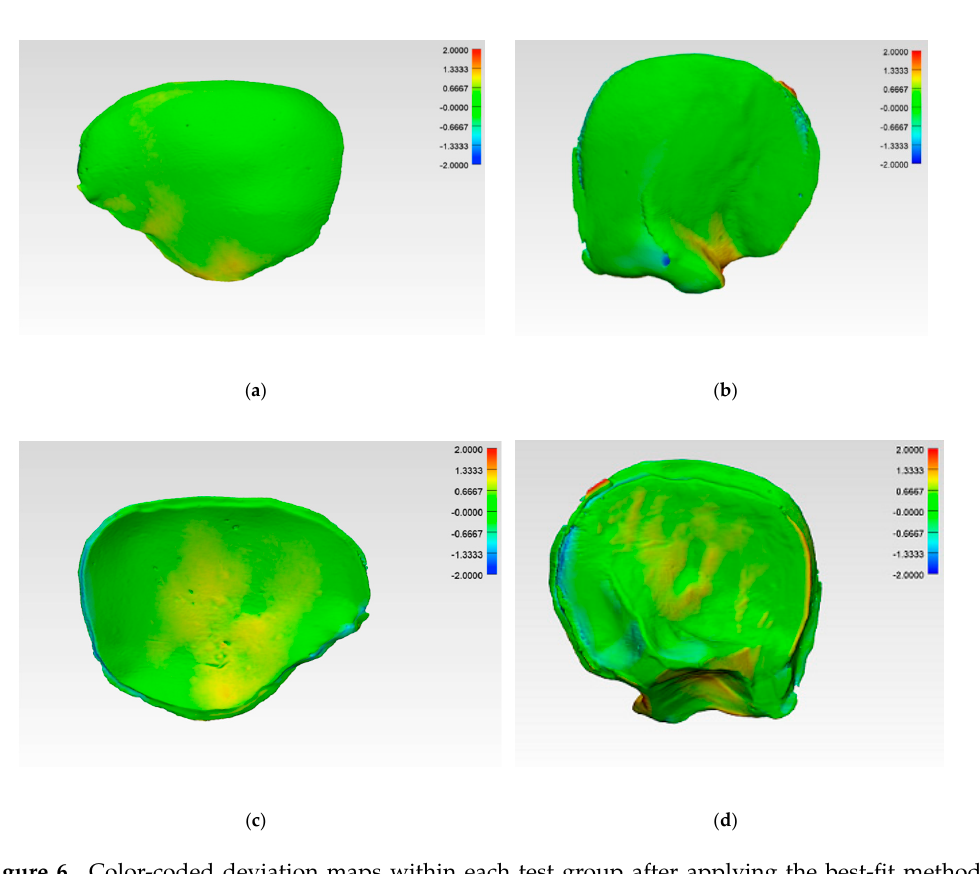
Figure 6. Color-coded deviation maps within each test group after applying the best-fit method and generating a 3D comparison to evaluate the accuracy. CRD-PSI: ( a ) squamous (outer) surface; ( c ) cerebral (inner) surface; TOD-PSI: ( b ) squamous (outer) surface; ( d ) cerebral (inner) surface.